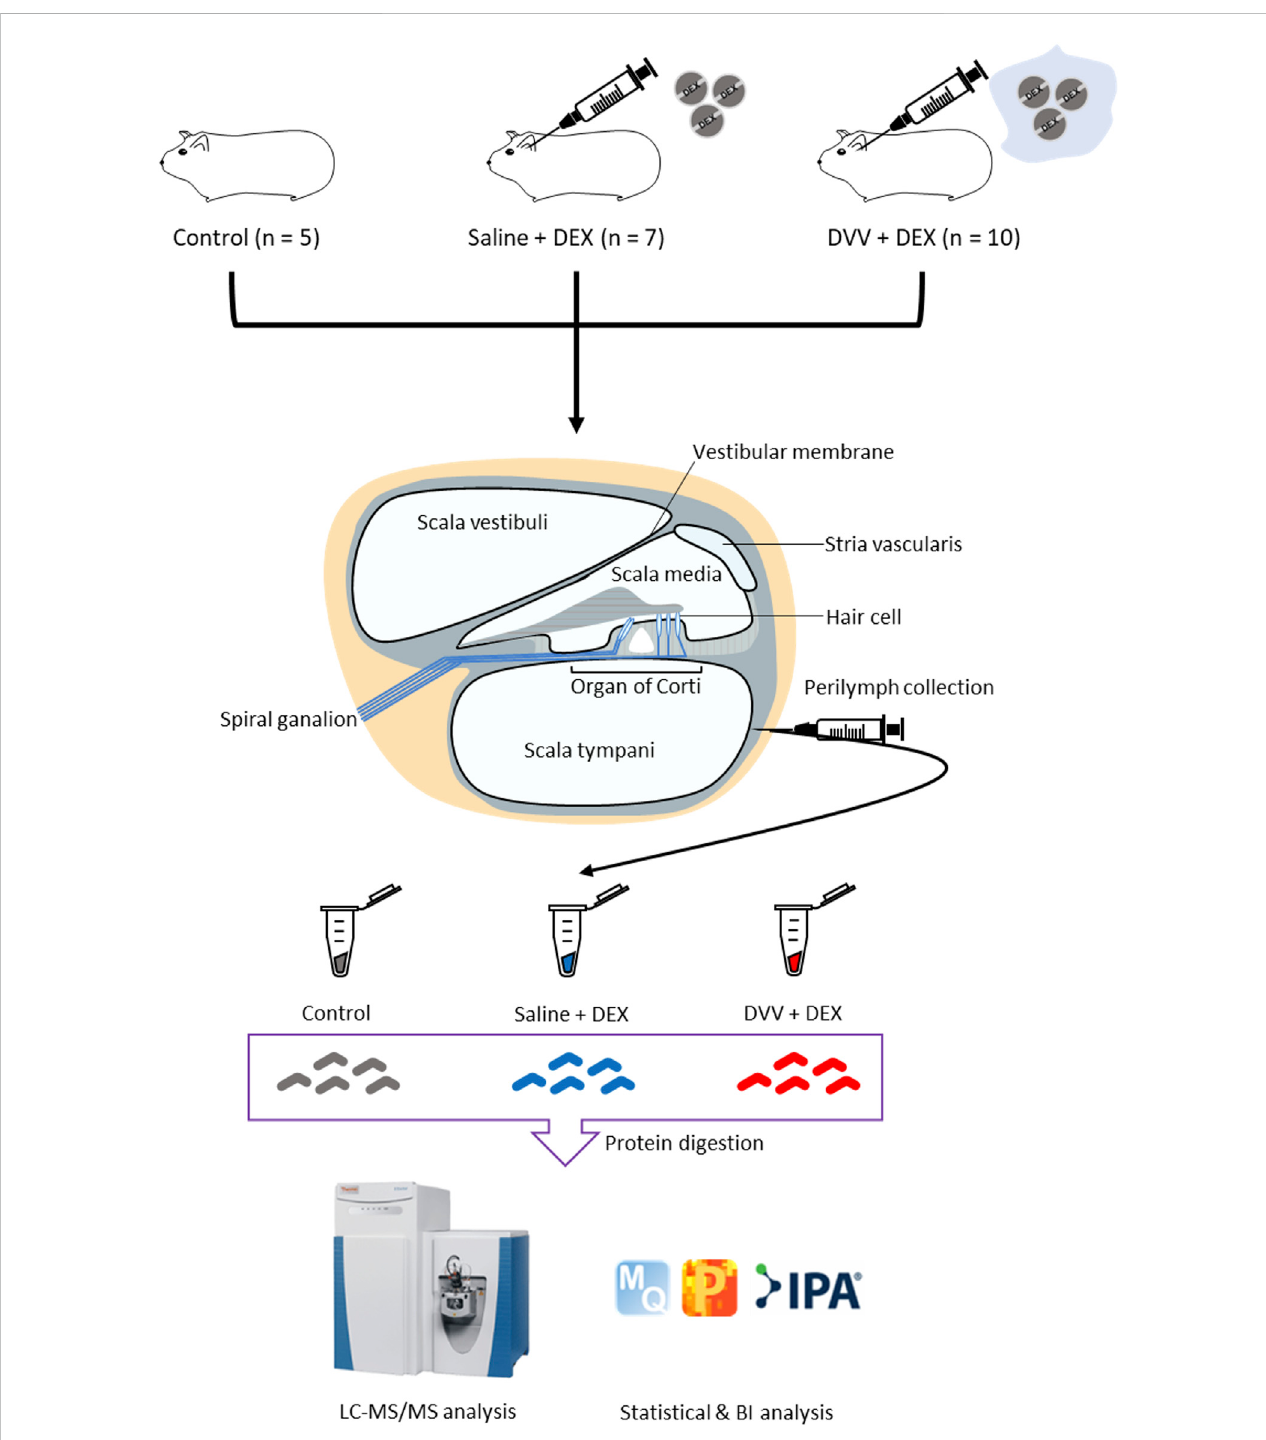
Overall scheme of proteomic analysis of guinea pig perilymph after dexamethasone treated carried by dual viscosity vesicle